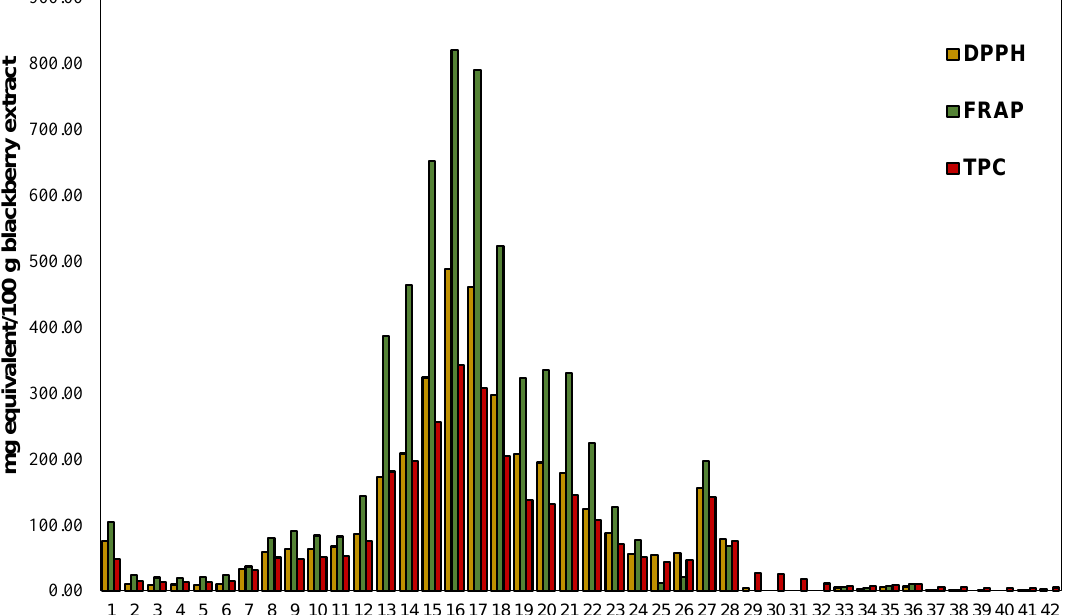
Figure 2. TPC (in gallic acid equivalent), DPPH, and FRAP both in Trolox equivalent of the FLC fractions of blackberry extract.